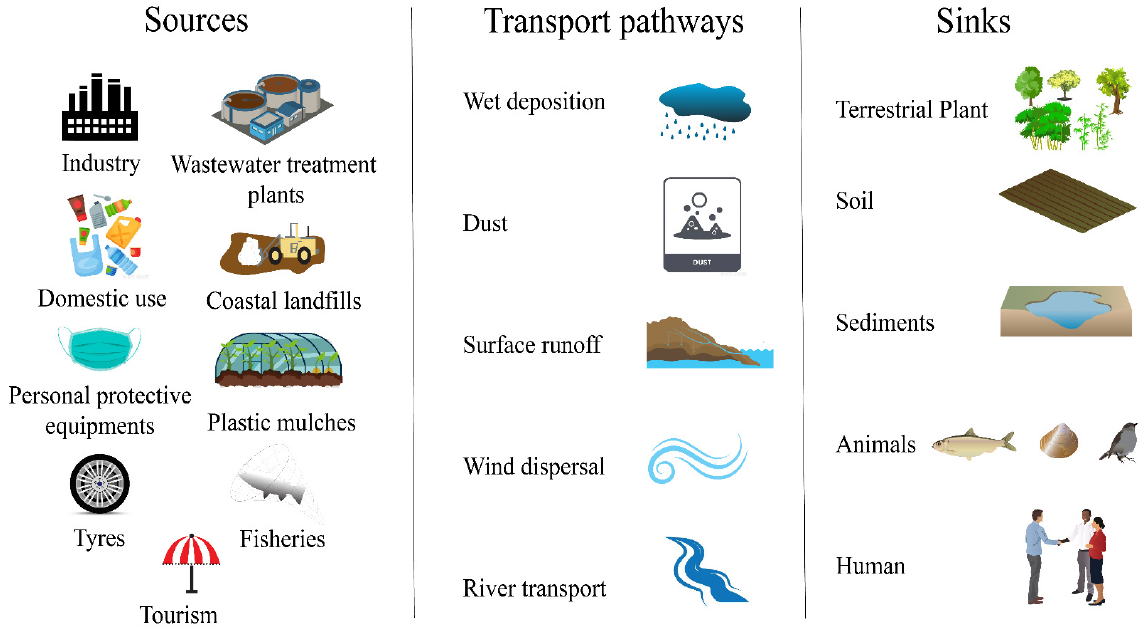
Figure 4. Microplastic sources, transport pathways, and sinks in coastal agglomerations (symbols from the IAN/UMCES Symbol and Image Libraries were used).